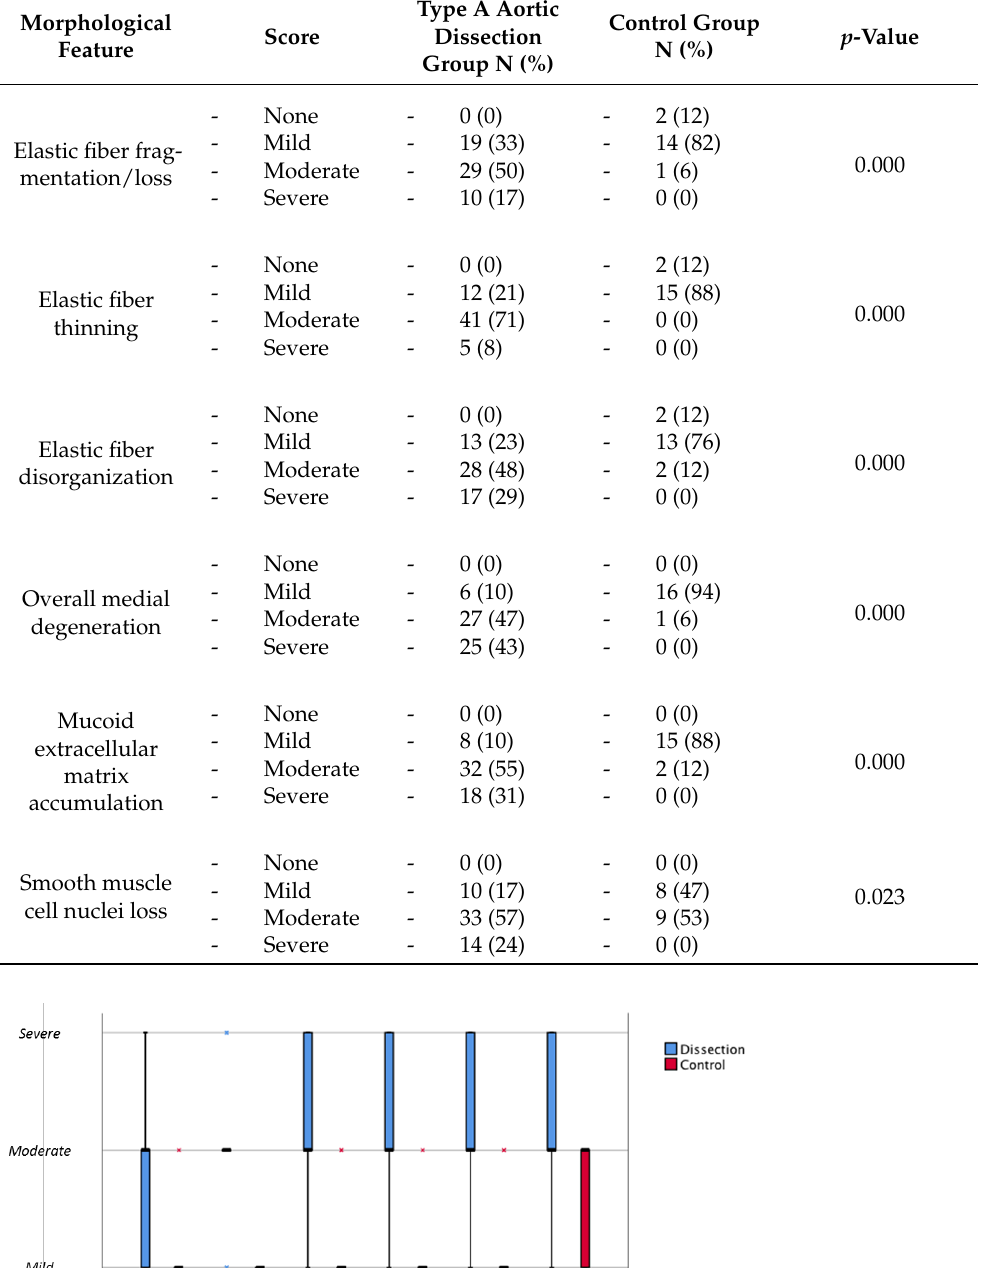
Table 3. Histomorphological features in the aortic dissection and control group.